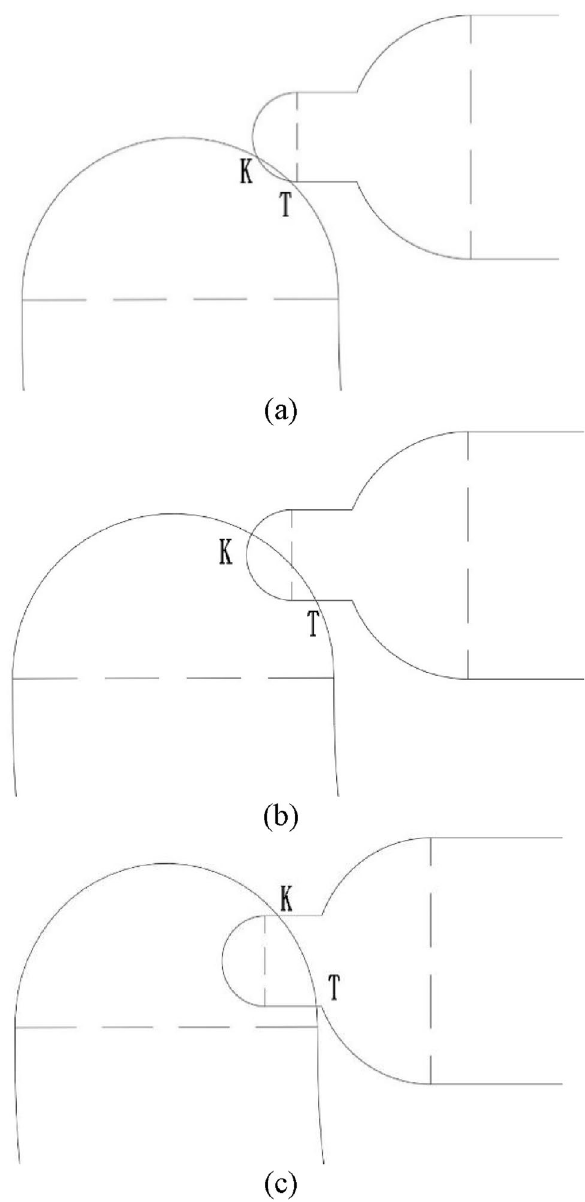
Figure 10. Theoretical analysis diagram of tangency between U-shaped buffer groove and waist groove of valve